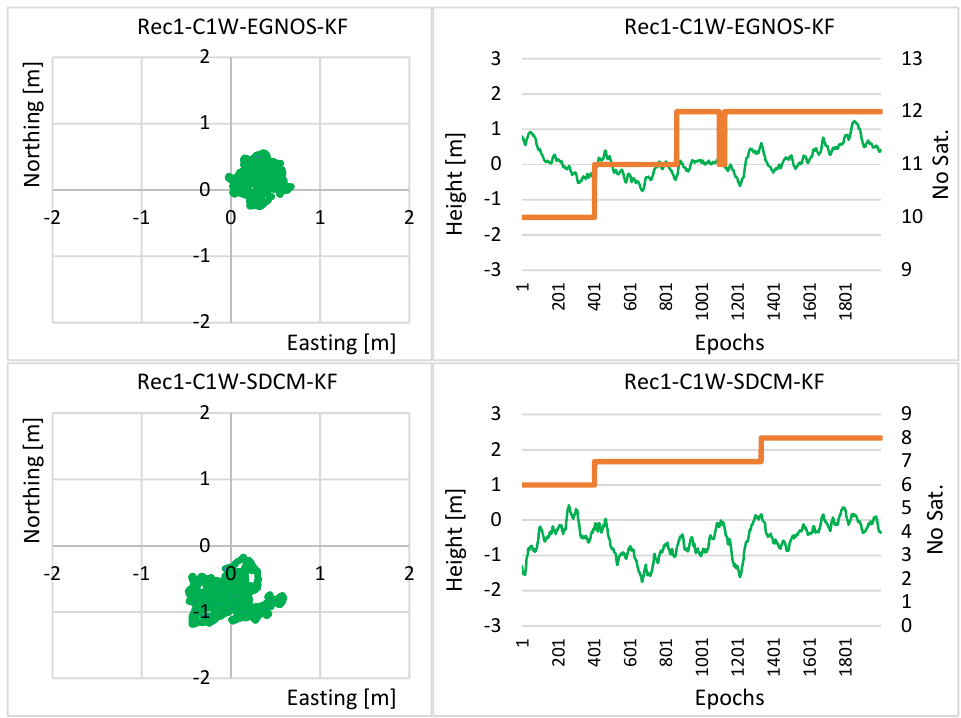
Figure 11. Real errors of horizontal and vertical coordinates of SBAS positioning based on C1W code, for the receiver Rec1 with EGNOS or SDCM corrections, with the use of Kalman filtering (Step III, see Figure 1).